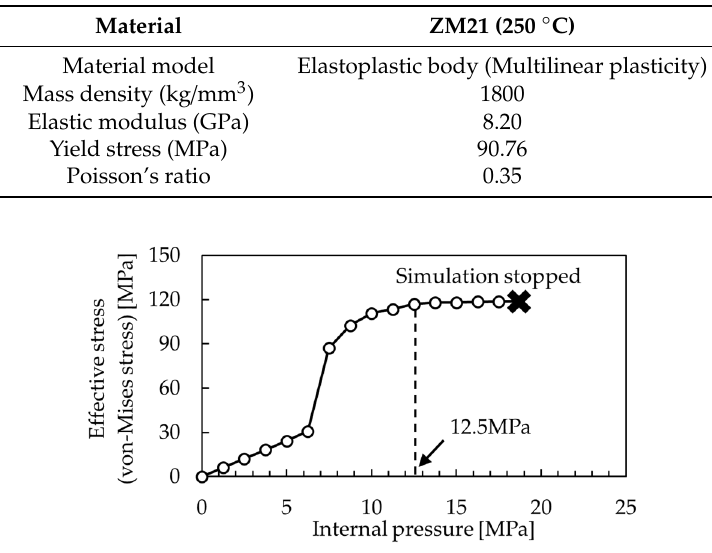
Figure 11. Definition of the bursting pressures of the small-diameter ZM21 tube in FEM at 250 °C.